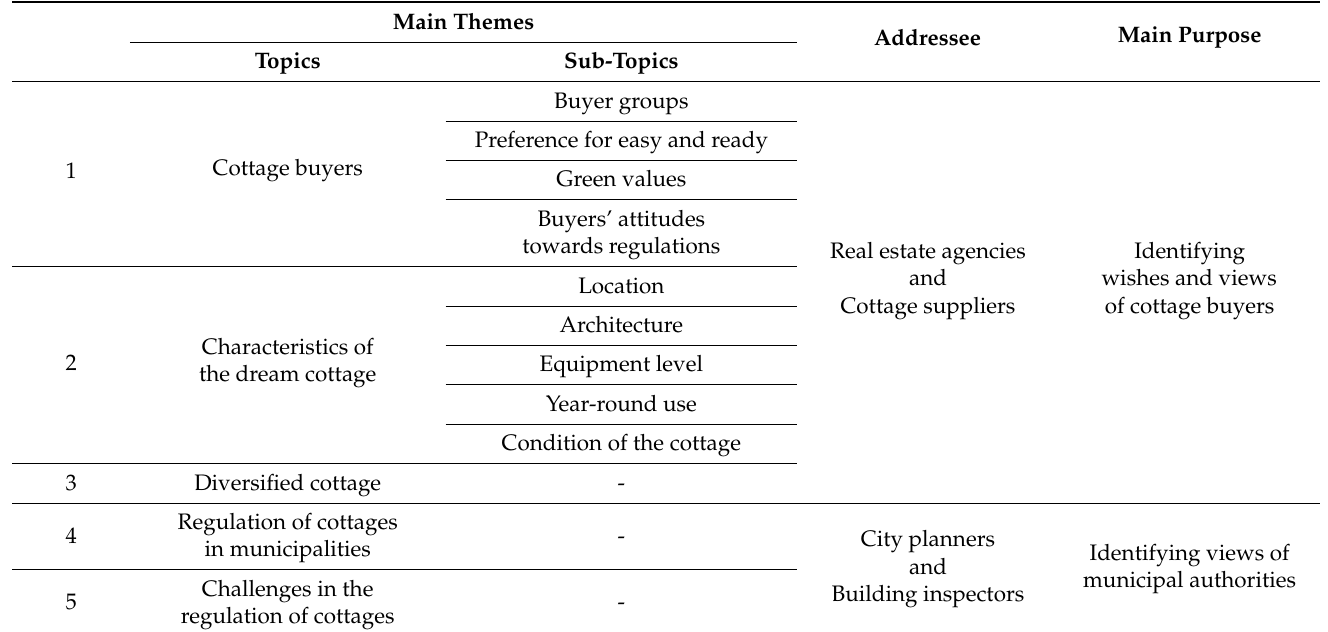
Table 2. The main themes, addressee, and main purpose of the interview